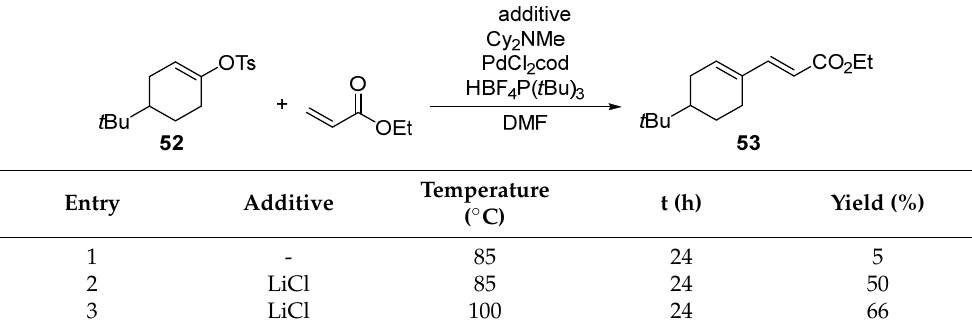
Table 11. Optimization of the coupling conditions by Skrydstrup et al.